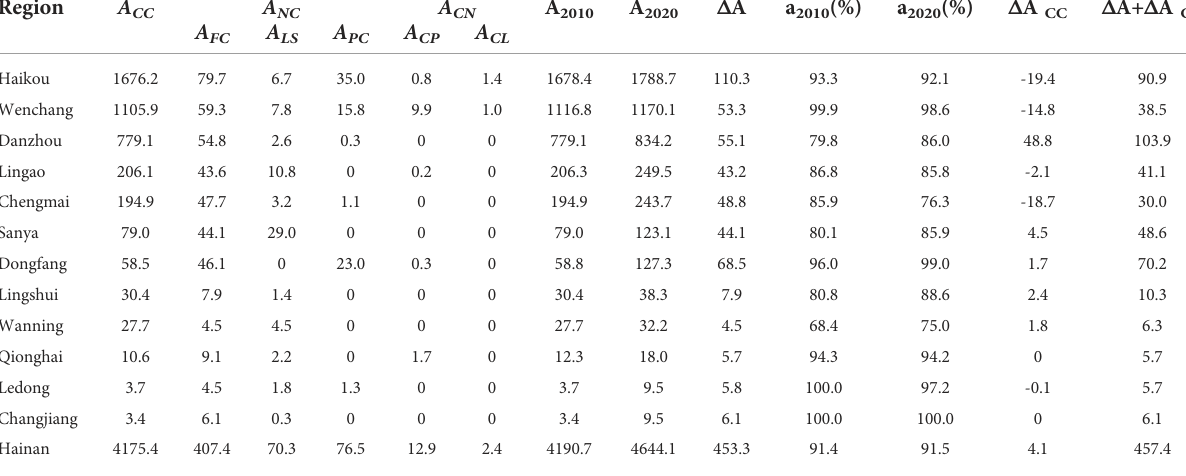
TABLE 2 Land-use change of coastal wetlands of Hainan between 2010 and 2020. Unit: ha. Region A